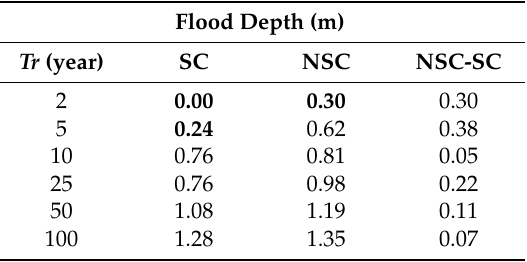
Table 13. Flood depth at cross-section K0+018.5.